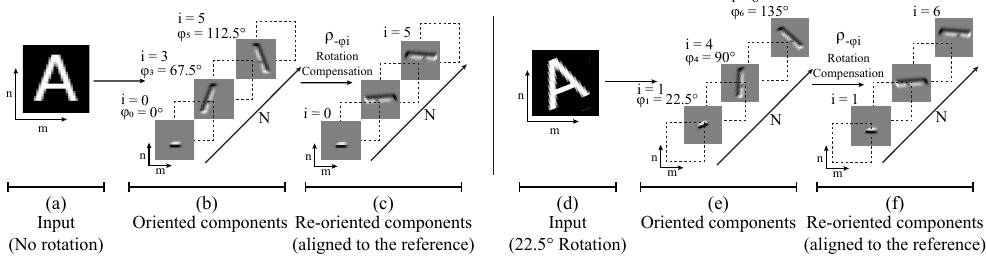
Figure 3. Oriented representation mapping to obtain roto-translational feature space. Left side: Up-right oriented input ( a ), and the oriented components ( b ) generate a translating output product of the rotation compensation ( c ). Right side: Rotated input ( d ) and the oriented components ( e ) with output translated by one space over axis N ( f